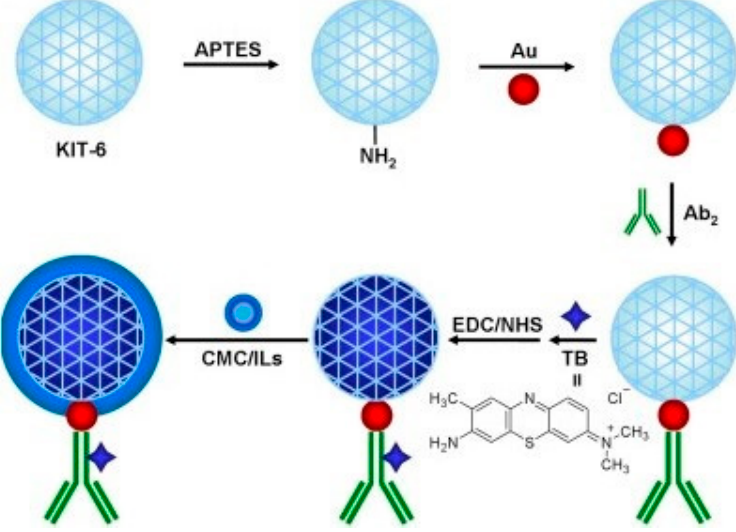
Figure 7. Preparation procedure of the TB/Au@KIT-6/CMC/ILs-Ab2 labels. Reproduced with permission from [45].